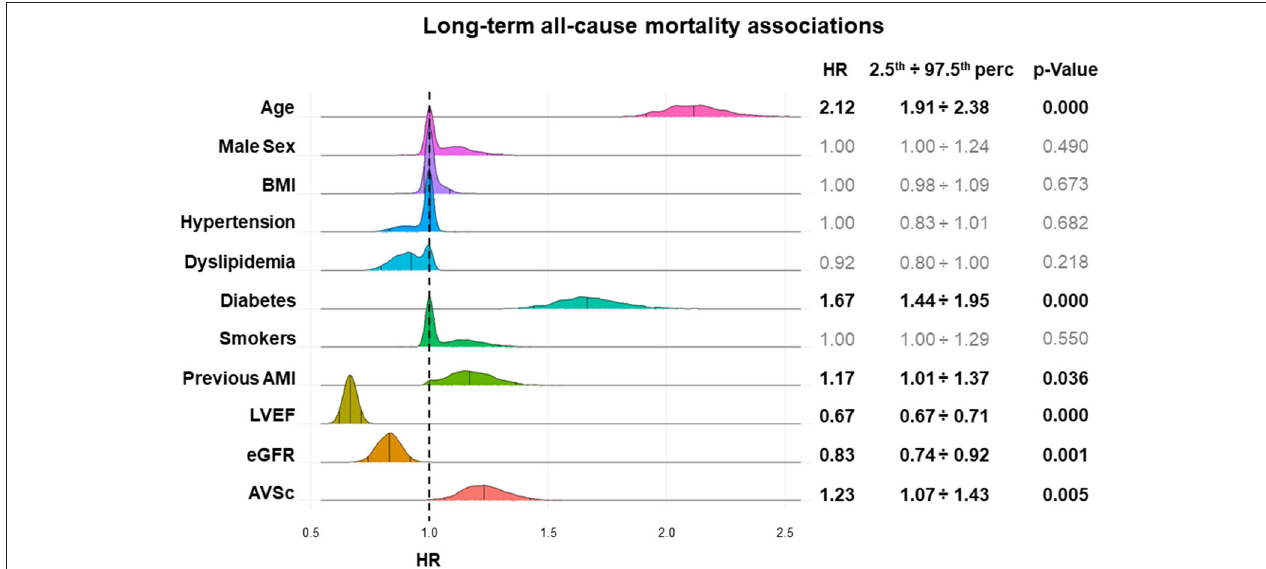
FIGURE 3 | Variables associated with long-term all-cause mortality in high-risk CAD patients. The plot shows the strength of the associations between cardiovascular risk factors or AVSc and 5-year all-cause mortality (hazard ratio–HR) and their distribution. For each variable, the results obtained from multivariable Cox LASSO regressions after 1,000 bootstrap iterations are depicted and the HR (median, 2.5th percentile, and 97.5th percentile) and significance level are reported. The y- axis represents the frequency of a specific HR, while the x-axis represents the HR estimated values. AMI, acute myocardial infarction; AVSc, aortic valve sclerosis; BMI, body mass index; CAD, coronary artery disease; eGFR, estimated glomerular filtration rate; LVEF, left ventricular ejection